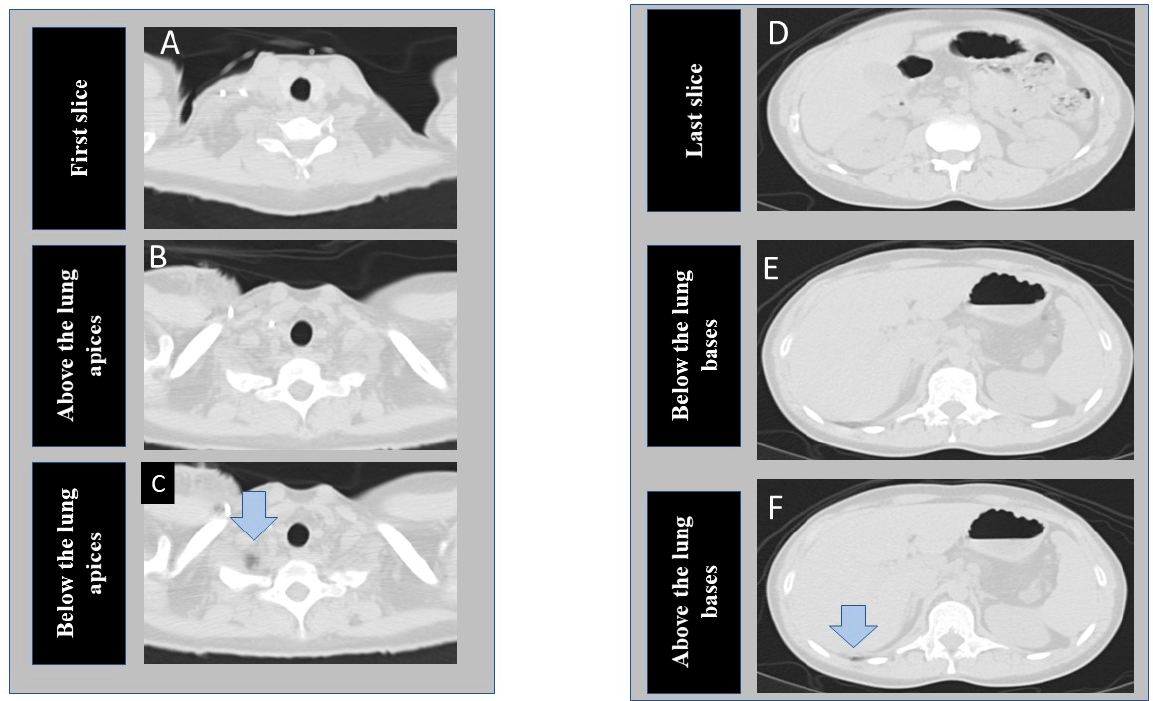
Figure 1. Transverse CT images at the superior ( A – C ) and inferior ( D – F ) scan locations of a chest CT examination. The first column shows the cranial-most (first image A ), perfect scan ( B ), and under-scanned ( C ) image locations at the lung apex. The second column of images represent caudal most image (last image D ), perfect scan location at lung base ( E ), and missed lung basilar anatomy ( F ). (The arrows point to tiny portions of lung parenchyma)